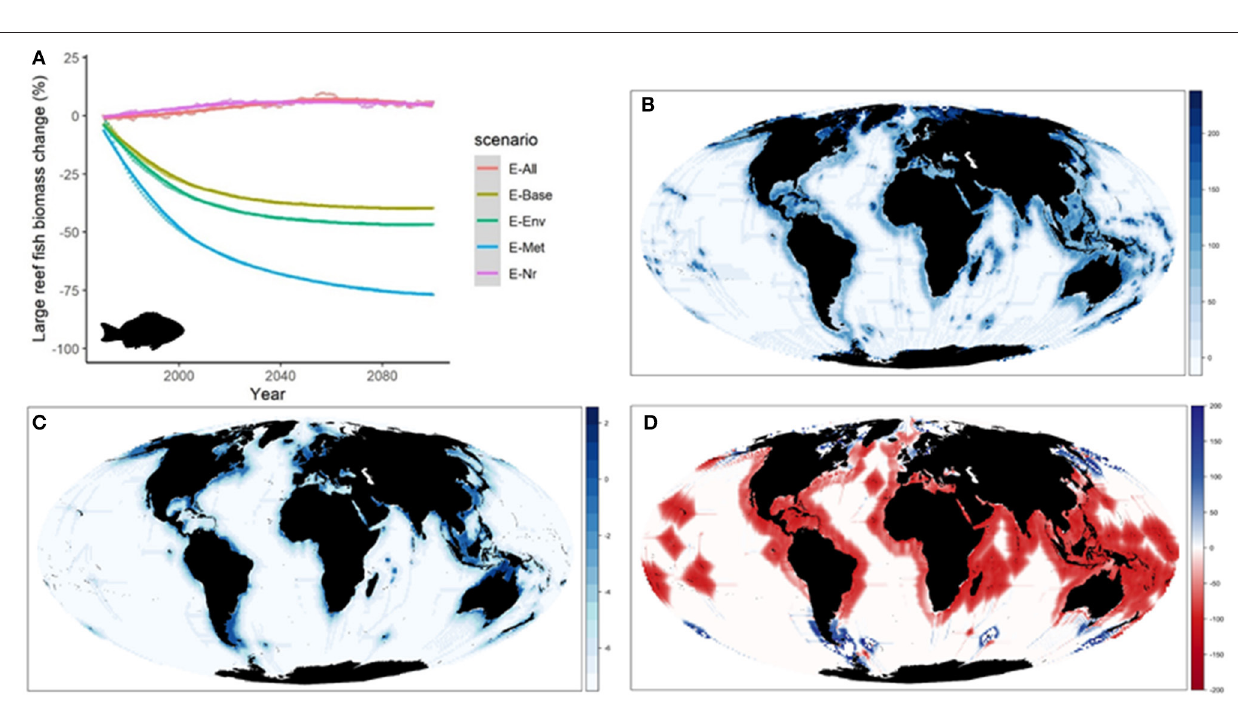
FIGURE 4 | Experiment 1 (Ecological configurations, Table 1 )—Changes in “Large reef fish” group: (A) Relative temporal change of biomass (%) obtained under the different ecological configurations of the model from 1970 to 2100, (B) Coefficient of Variation of biomass in 2100 under the different ecological configurations, (C) Biomass (log10) distribution in 2100 under configuration E-All, and (D) Relative change (%) of biomass between 1970 and 2100 under configuration E-All (Fish images source: IAN,